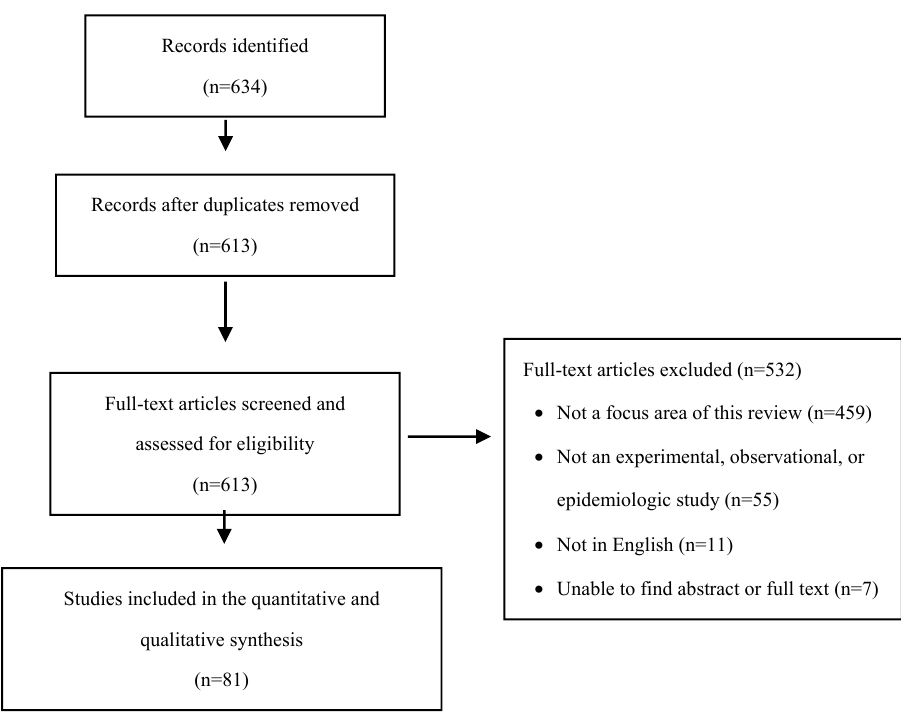
Figure 1. PRISMA flow diagram of study inclusion.